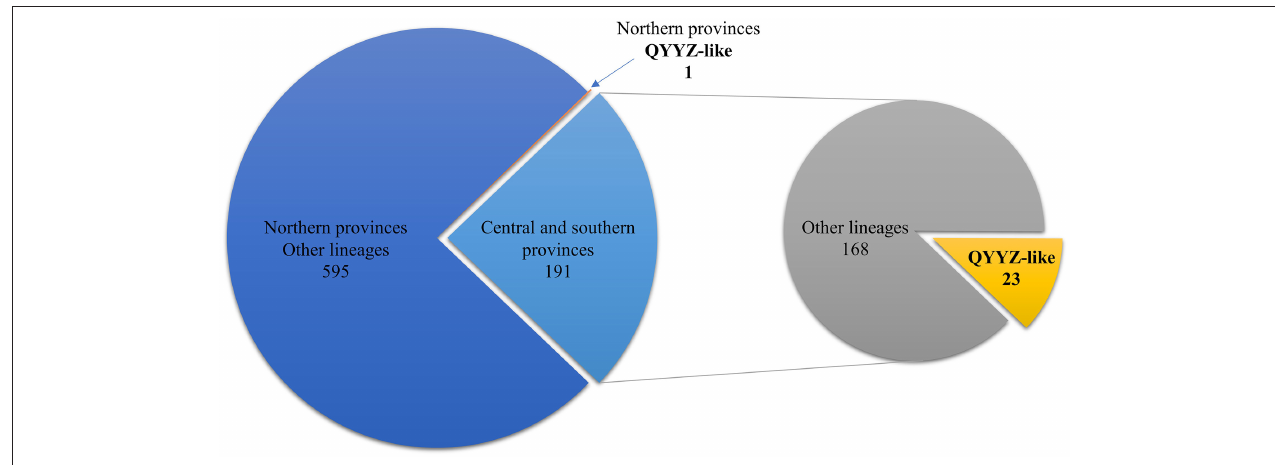
FIGURE 1 | Number of QYYZ-like strains detected in different regions from 2018 to 2021. Among the 596 PRRSV-positive samples from northern provinces, 1 was a QYYZ-like strain. The remaining 191 PRRSV-positive samples were from central and southern provinces, of which 23 were QYYZ-like strains.